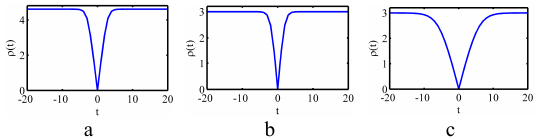
Figure 5. The robust function  ( t ) with different parameters. (a) e =0.01,  =0.6; (b) e =0.05,  =0.6; (c) e =0.05, 